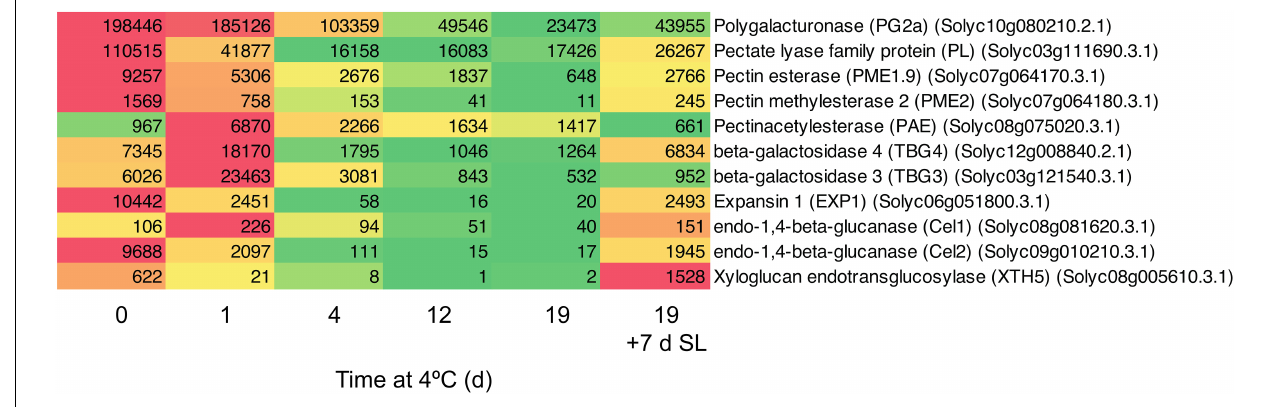
FIGURE 4 | Heat map showing cell wall modification-related genes differentially expressed in response to storage at 4 ◦ C. An additional 7-day period at a shelf-life (SL) temperature of 20 ◦ C was also included after 19 days. Red and green colors represent high and low mRNA abundance, respectively, within each transcript. Numbers in the boxes are DESeq2 mean normalized counts using the median of ratios